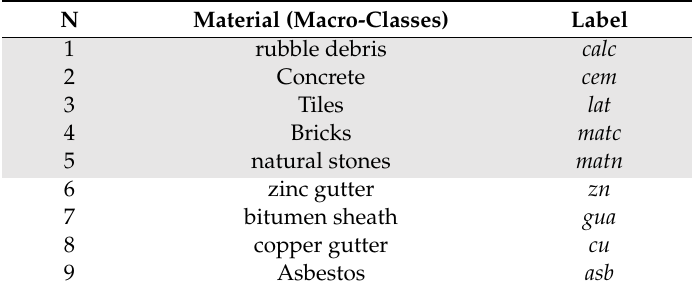
Table 1. Considered urban rubble